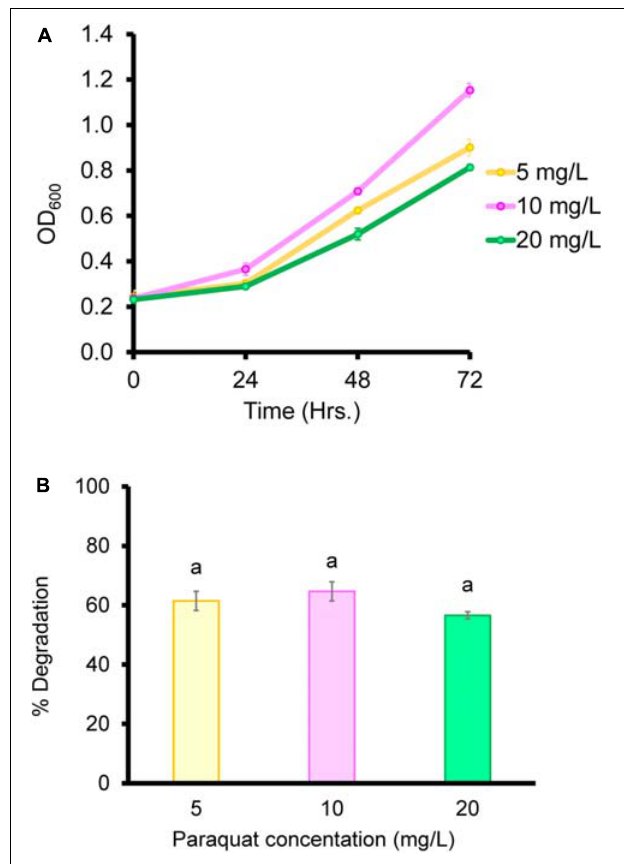
FIGURE 5 | Growth of bacteria in paraquat as a sole carbon source and on paraquat degradation.